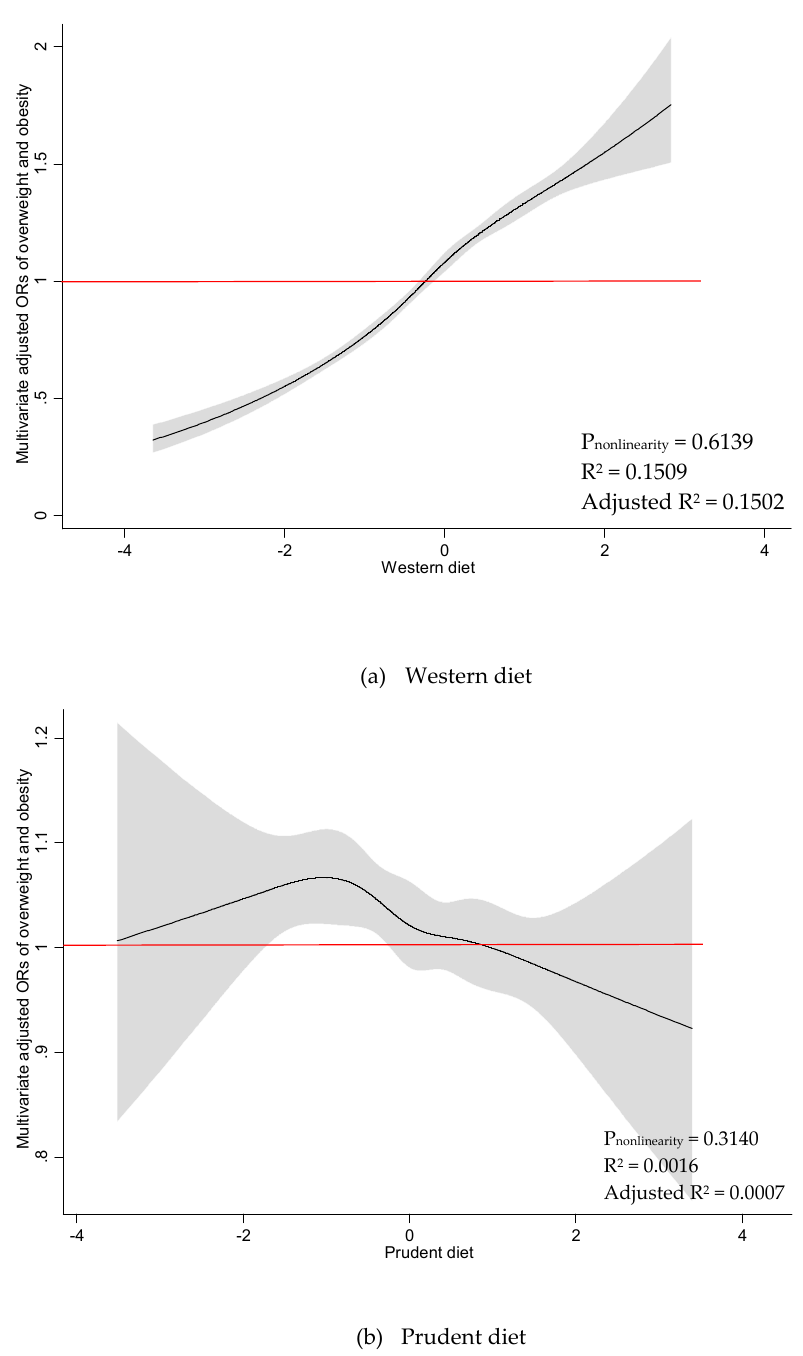
Figure 1. Restricted cubic spline plots between dietary patterns and multivariate adjusted odds ratio of overweight and obesity among all participants. ( a ) Western diet and ( b ) Prudent diet. Results obtained by multivariable logistic regression with restricted cubic splines with five knots. Solid black lines indicate odds ratio, and shaded areas indicate 95% CI.